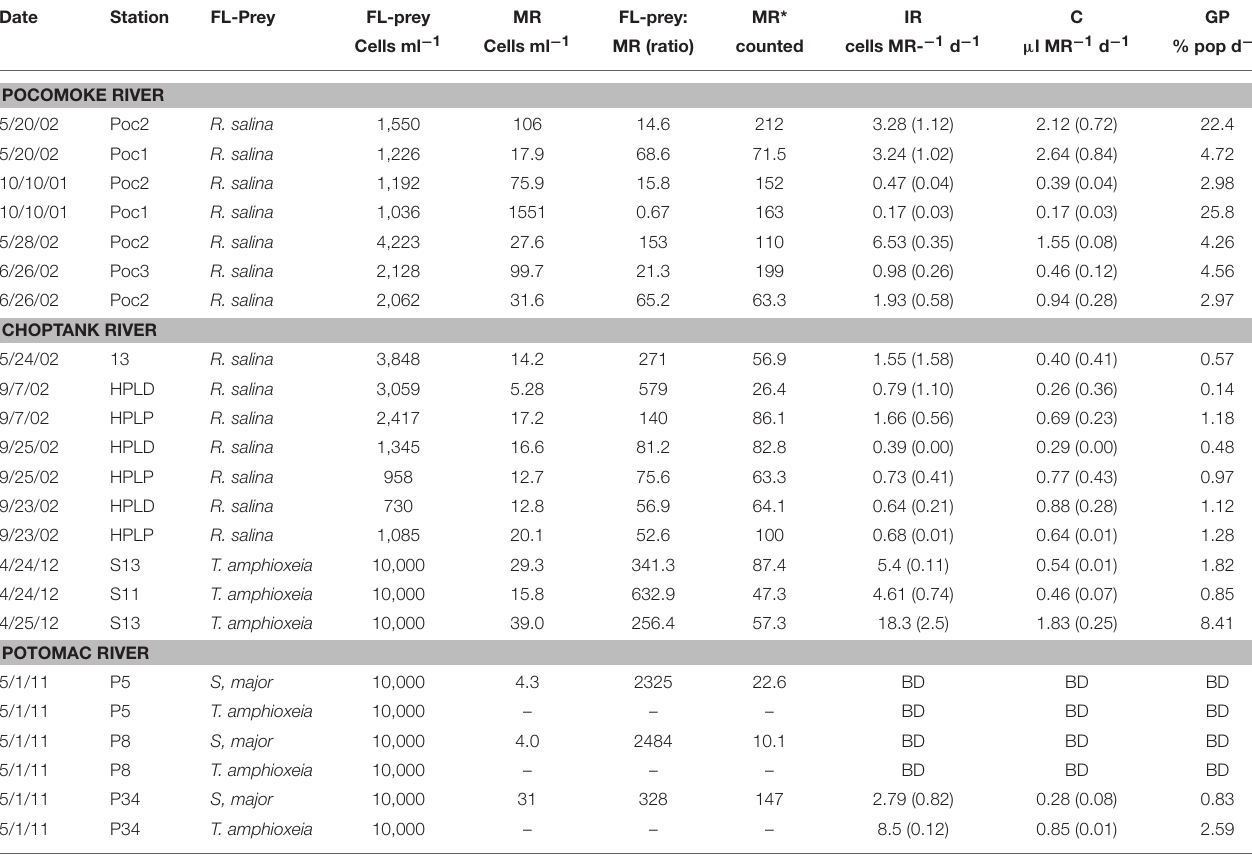
TABLE 3 | Grazing rates of Mesodinium rubrum (MR)-like ciliates in Chesapeake Bay Tributaries on fluorescently labeled (FL) cryptophyte algae. Date Station FL-Prey